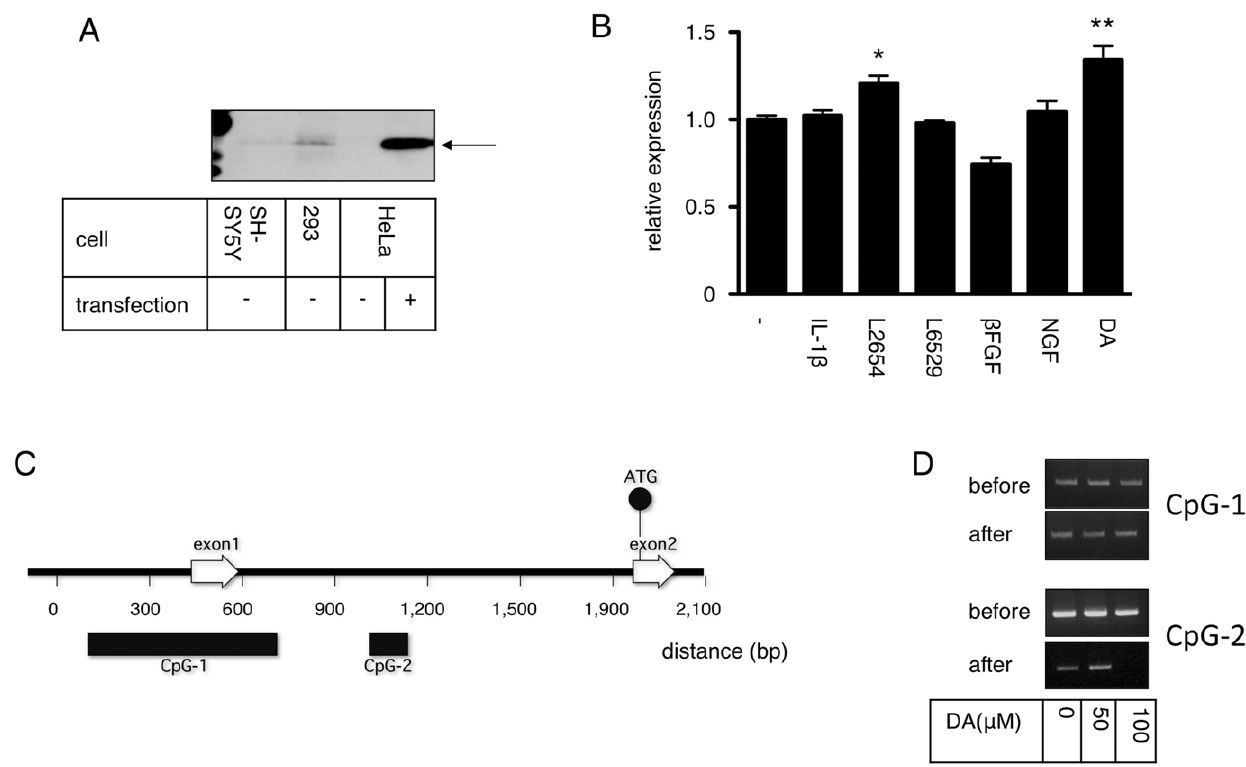
Figure 1. Identification of SNCA CpG islands. A : 293 cells express endogenous alpha-synuclein Immunoblot of cell lysates from SH-SY5Y, 293, and HeLa cells with or without over-expression of wild-type alpha-synuclein (transfection 2 and + ). Arrow indicates alpha-synuclein. B : Quantification of alpha-synuclein expression in the presence of various stimuli. DMSO ( 2 ), IL-1 b (100 ng/mL), lipopolysaccharides (L2654 and L6529 1 m g/mL), b FGF (100 ng/mL), NGF (100 ng/mL) and dopamine (DA 50 m M) were added to 293 cells for 48 h and relative expression of alpha-synuclein was compared by quantitative RT-PCR. Relative amounts of alpha-synuclein mRNA were normalized to DMSO=1.0, * P , 0.01, ** P , 0.001. C : Structure of the SNCA CpG island Entrez gene NC_000004.11 ID was analyzed by CpG island search software (http://www.uscnorris.com/cpgislands2/cpg.aspx.). Non-coding exon1 and coding exon2 are indicated by open arrows. The translation start ATG codon (methionine) located at exon2 is indicated by a closed circle. Two separate CpG islands are indicated by closed bars. D : Methylated-CpG island recovery assay of dopamine treated cells. 293 cells treated with or without dopamine were lysed and methylated. CpGs were enriched by MBD2 protein. Methylated CpG-1 or CpG-2 was detected by PCR before and after enrichment.